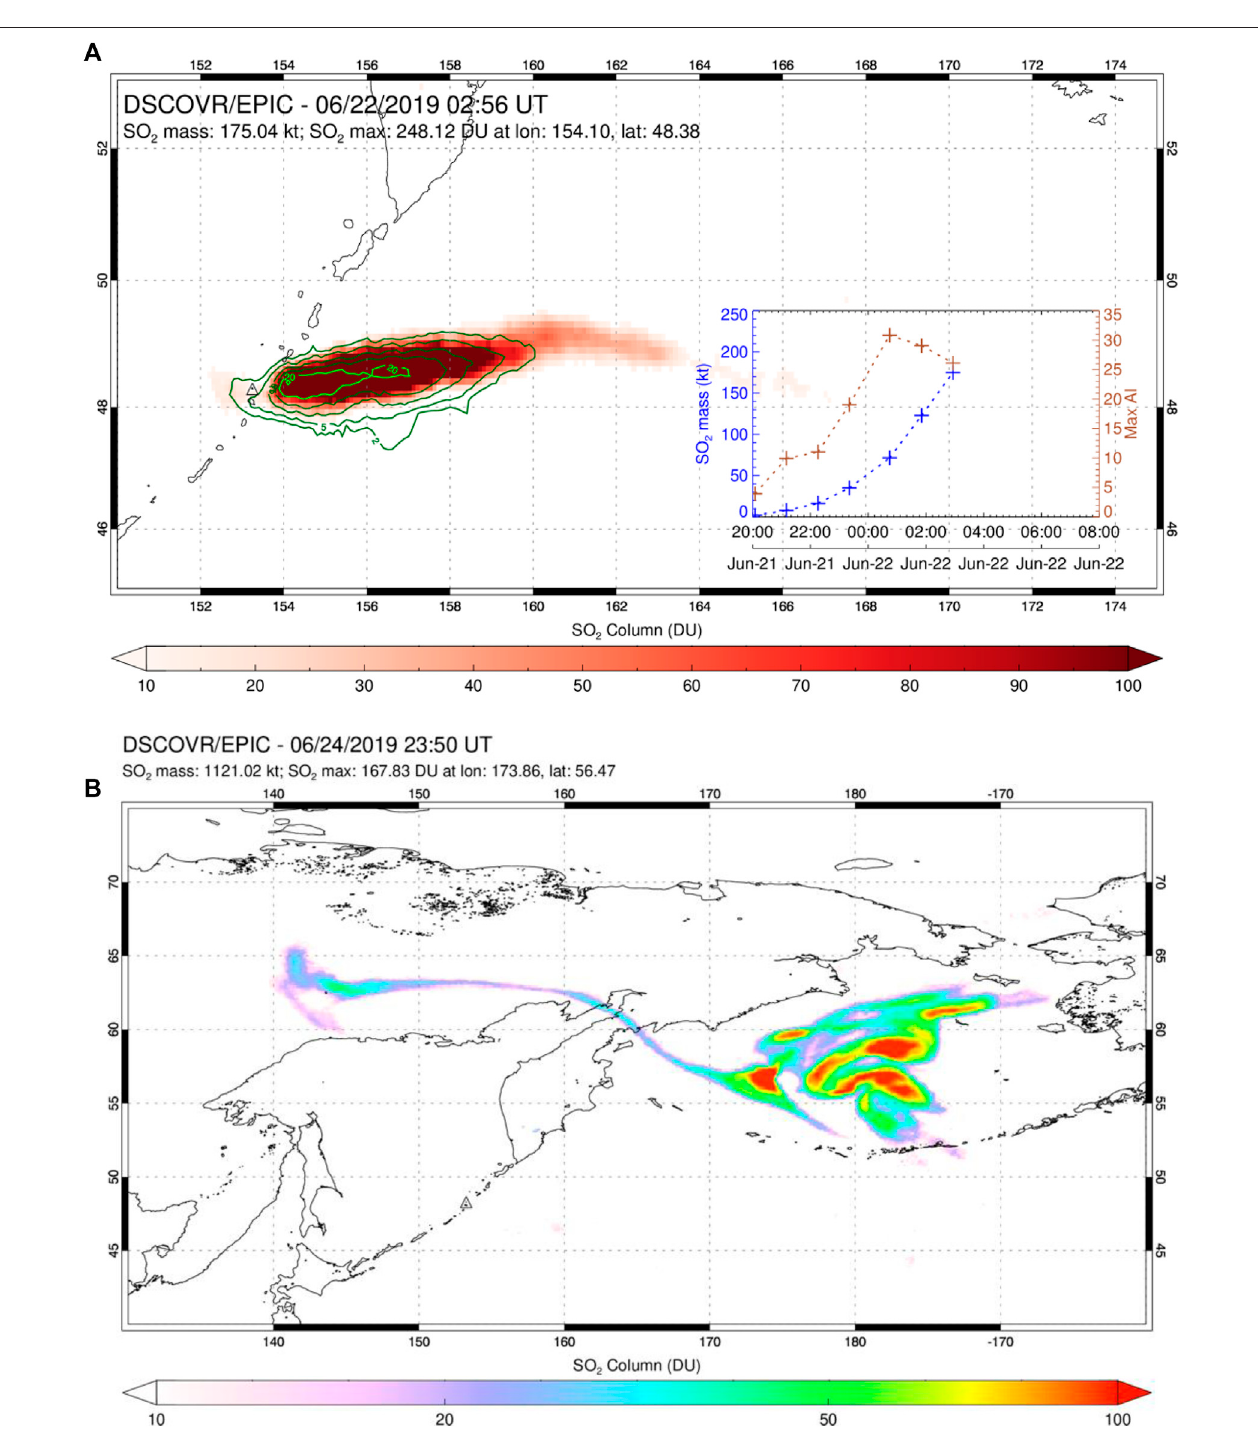
FIGURE 5 | (A) EPIC SO 2 and UV Aerosol Index (UVAI; green contours ) measurements during the eruption of Raikoke volcano (Kuril Islands, Russia; triangle ) on June 22, 2019 at 02:56 UT. The UVAI is used to detect volcanic ash. Inset lower right shows a time-series of volcanic SO 2 mass and UVAI derived from EPIC measurements with hourly cadence during the eruption. (B) EPIC SO 2 retrieval for the high-latitude Raikoke volcanic cloud on June 24 at 23:50 UTC. EPIC was able to capturethisextensive,high-latitudevolcaniccloudinsinglesynopticimageswithhourlycadence,whereassuchlatitudesaretowardstheedgeofthegeostationary (GEO) fi eld-of-view and can only be covered by multiple overpasses of polar-orbiting (LEO) instruments (with inter-orbit gaps of ∼ 100 min).